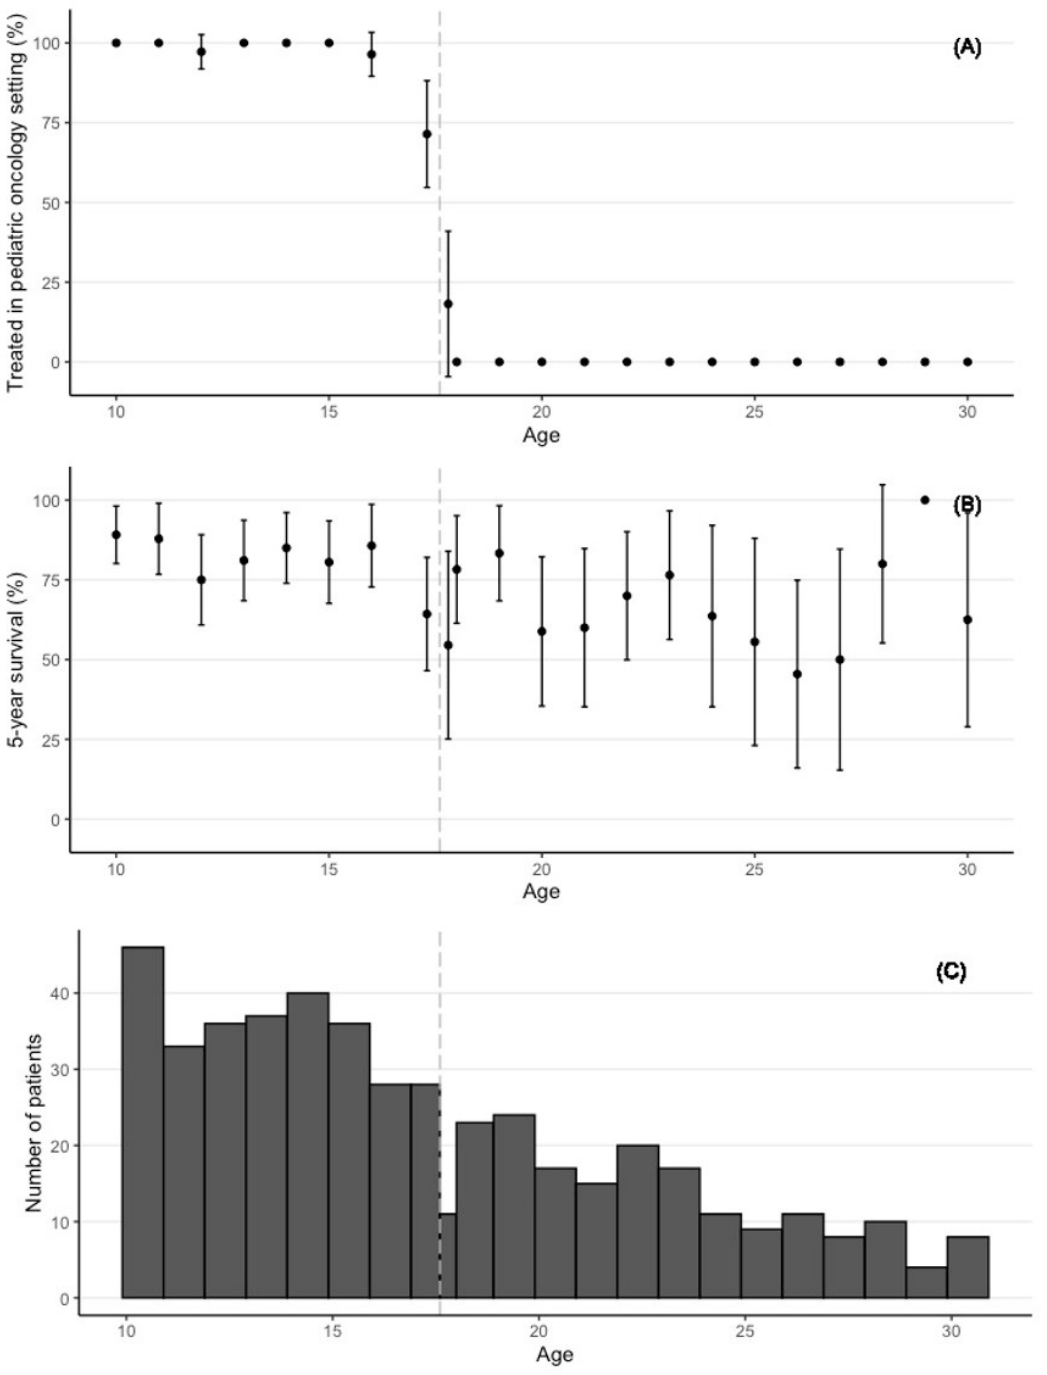
Figure 1. ( A ) The percentage of the patients by age that were treated in specialized pediatric hemato- oncology care. ( B ) Unadjusted 5-year survival as a percentage of patients by age. ( C ) Number of patients by age. In panels ( A , B,C ), the vertical dashed lines represent the treatment threshold at 17 years and 7 months.